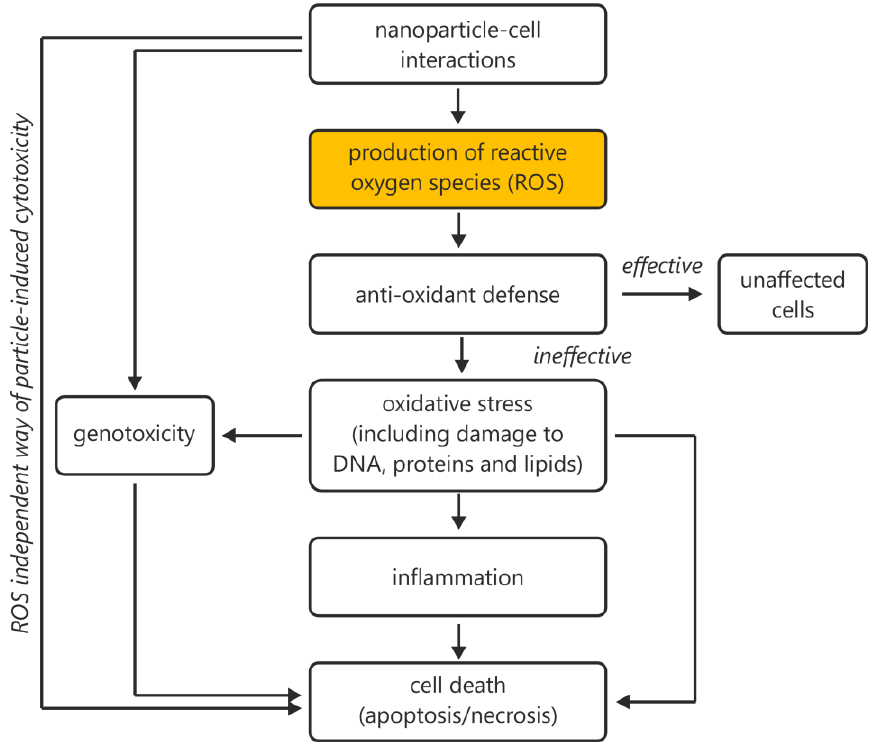
Figure 1. Nanoparticle–cell interactions with a central role for reactive oxygen species (ROS). Summary of possible cellular reactions taking place after nanoparticles (NPs) interact with cellular